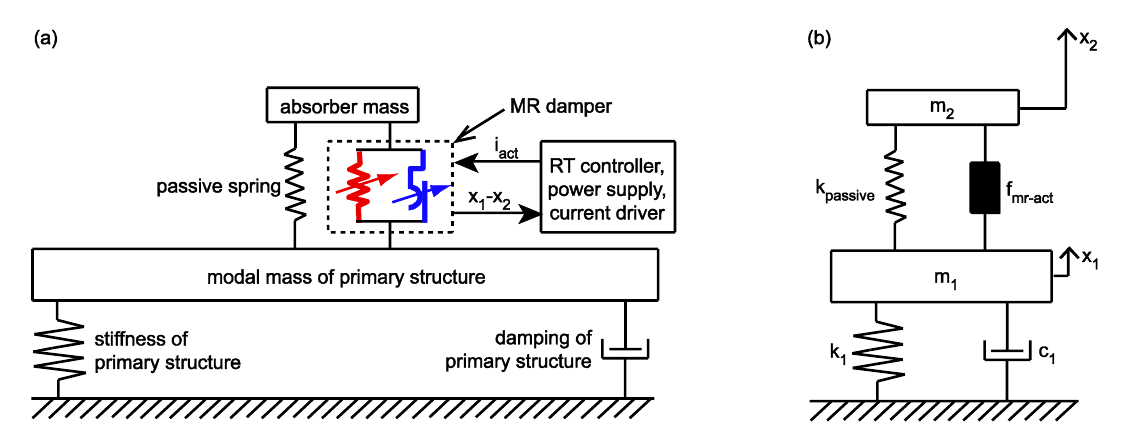
Figure 1. ( a ) MR-SVA with real-time frequency and damping controls based on the emulations of controllable stiffness and friction forces in the MR damper and ( b ) equivalent mechanical model.